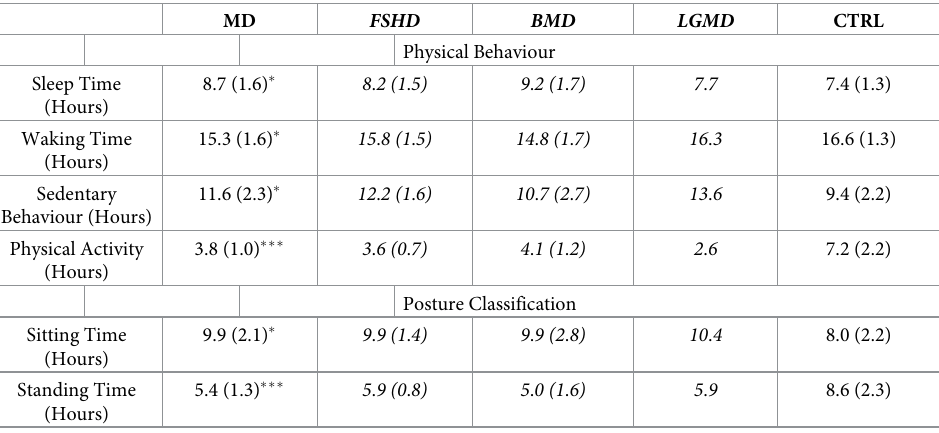
Relative Sedentary Behaviour was 18 percentage points greater in adults with MD com- pared to CTRL ( p < 0.001), and Physical Activity was 18 percentage points lower in adults with MD compared to CTRL ( p < 0.001). Relative (percentage of Waking Hours) Sitting Time was 17 percentage points greater in adults with MD compared to CTRL ( p = 0.001) and Rela- tive Standing Time was 17 percentage points lower in adults with MD compared to CTRL ( p = 0.001, See Fig 1). Associations between physical behaviour and posture classification with body composition and function Absolute hours of Physical Activity in ambulatory adults with MD was associated with both Fat Mass (Kg) (R = -0.654, p < 0.05), Fat Mass (%) (R = -0.585, p < 0.05), 10m walk time Table 2. Accelerometer determined physical behaviour and posture classification (absolute).